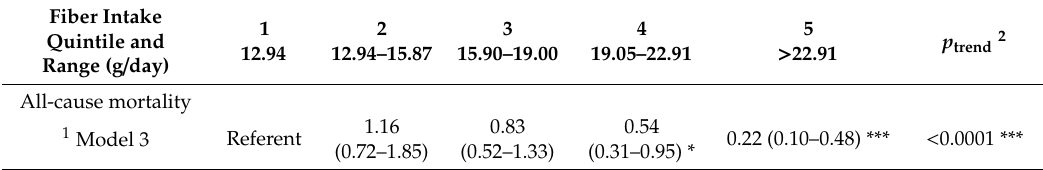
Table 4. Propensity score-weighted multivariable hazard ratios and their 95% confidence intervals of all-cause mortality risk by pretreatment total dietary fiber consumption